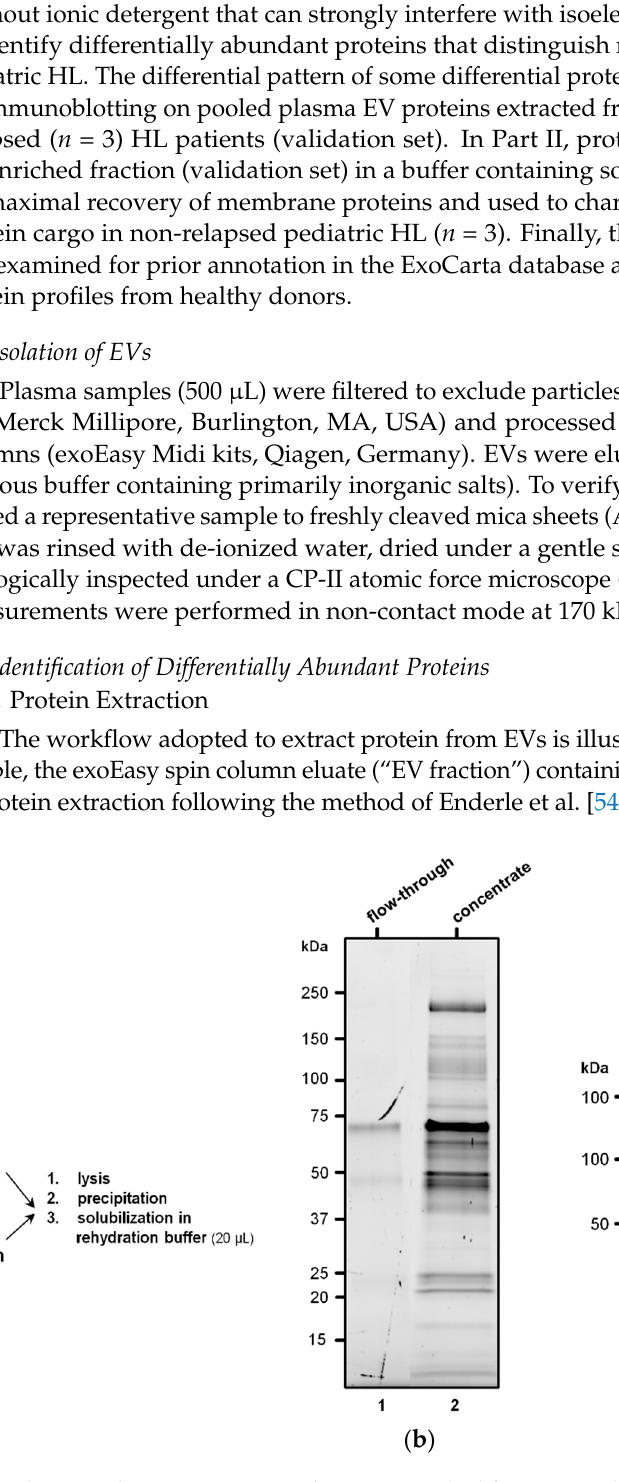
Figure 1. Details of the experimental approach to extract protein from EV-enriched fractions and exclude contamination of non-EV proteins. ( a ) EV-enriched fractions were concentrated with 100,000 molecular weight cut-off concentrators, and both the flow-throughs and concentrates were subjected to lysis and then purification by precipitation and solubilization in rehydration buffer (around 20 µ L). ( b ) Image of a stain-free gel before protein transfer to nitrocellulose membrane: proteins from flow-throughs (10 µ L) and concentrates (10 µ L corresponding to 10 µ g) were separated by SDS-PAGE. ( c ) Blot probed with primary antibodies against ALIX, CANX, and